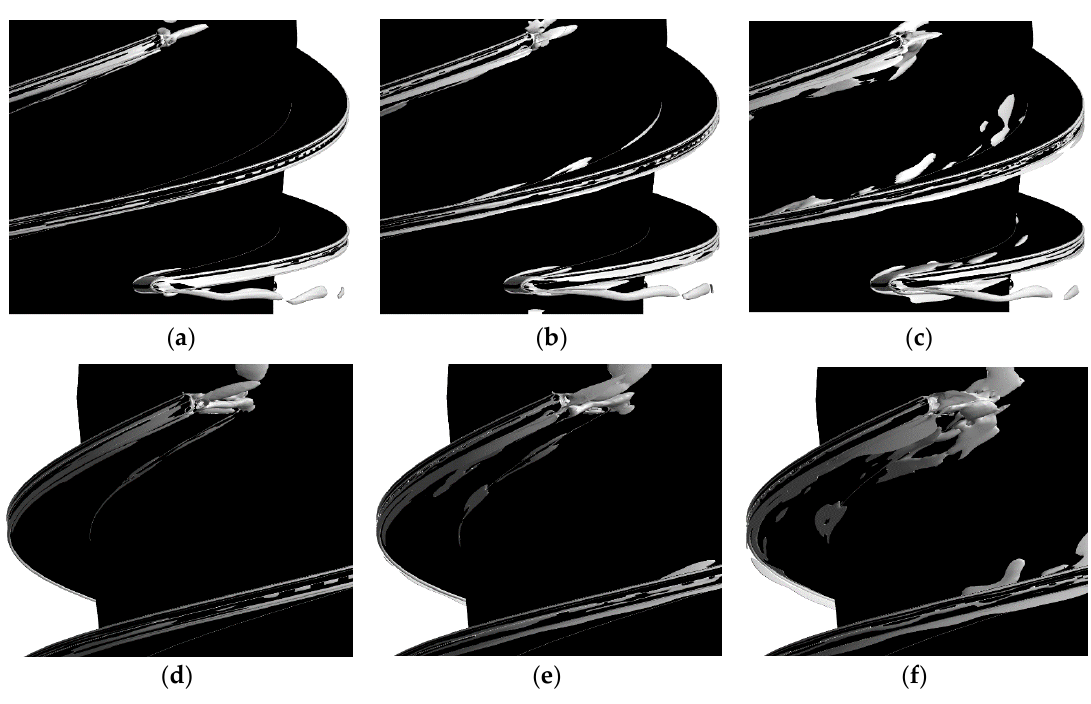
Figure 11. Vortex structure at blade leading edge and trailing edge. ( a ) Leading edge of GVF = 5%; ( b ) leading edge of GVF = 10%; ( c ) leading edge of GVF = 15%; ( d ) trailing edge of GVF = 5%; ( e ) trailing edge of GVF = 10%; ( f ) trailing edge of GVF = 15%.